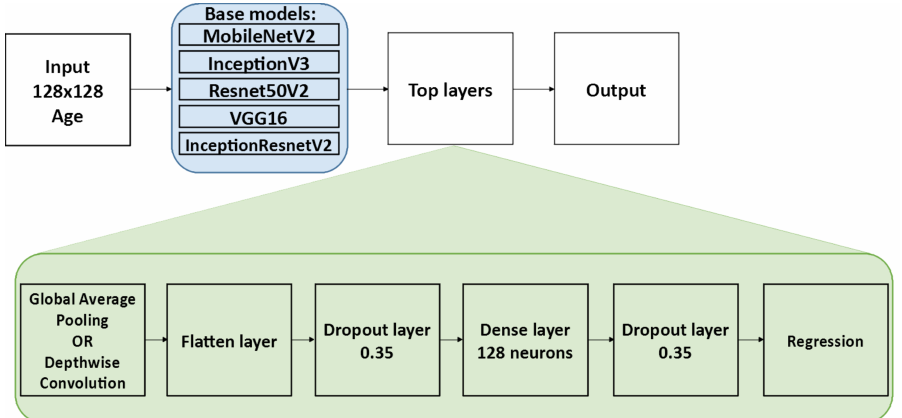
Figure 3. Scheme of proposed models used in the study. A preprocessed input image was first processed by the base model. Five different base models were investigated as indicated by the blue block. Features extracted by the base model were provided as an input for the head model. The first layer of the head model was either depthwise convolution or global average pooling. Both methods were investigated together with the fixed set of remaining layers of the head model presented in the